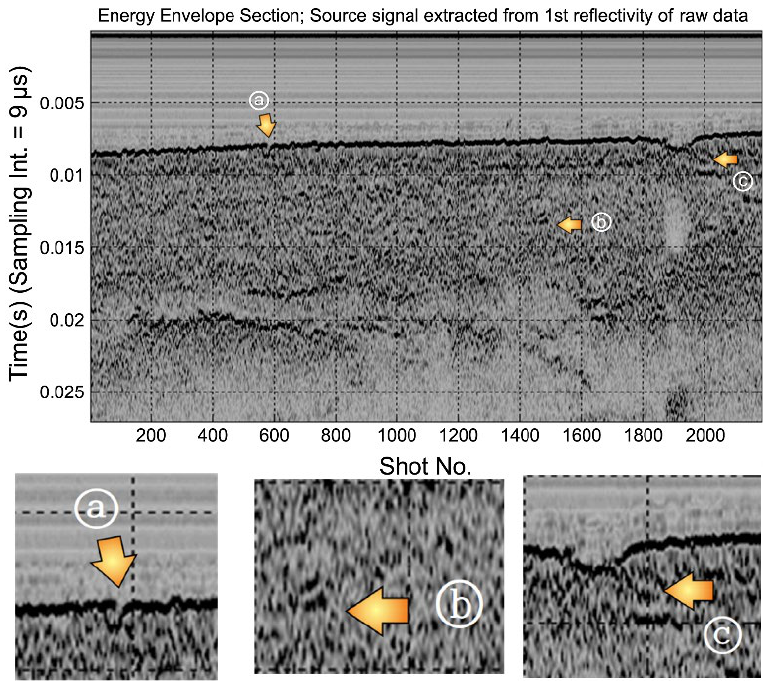
Figure 13. Chirp sub-bottom profiler (SBP) envelope section generated with Source II.